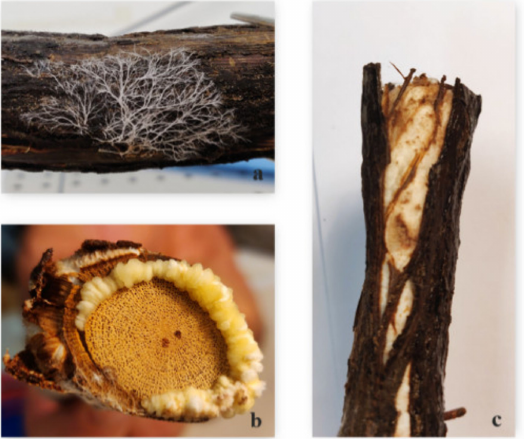
Figure 6. Panel ( a ) shows an example of the typical mycelial fan of Armillaria spp. found on incubated roots; panel ( b ) shows an example of the Armillaria subcortical mycelium; panel ( c ) shows the longitudinal bark breaking caused by the mycelium expansion. From the author, Edmund Mach